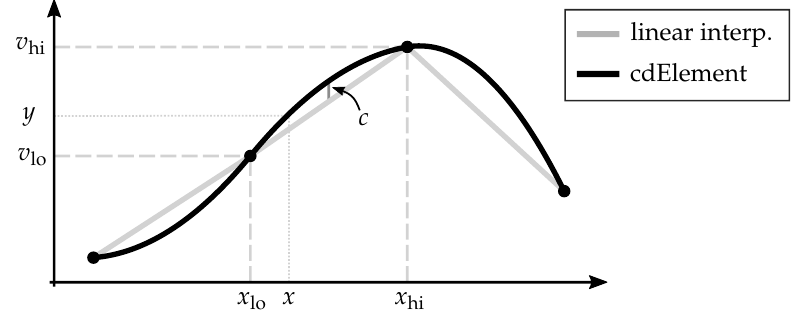
Figure A1. Illustration of a one-dimensional continuously differentiable look-up